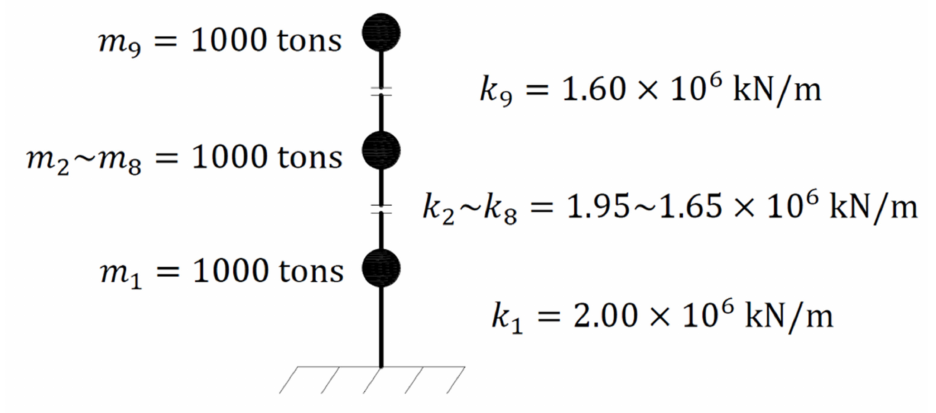
Figure 3. Simulation model of nine-story